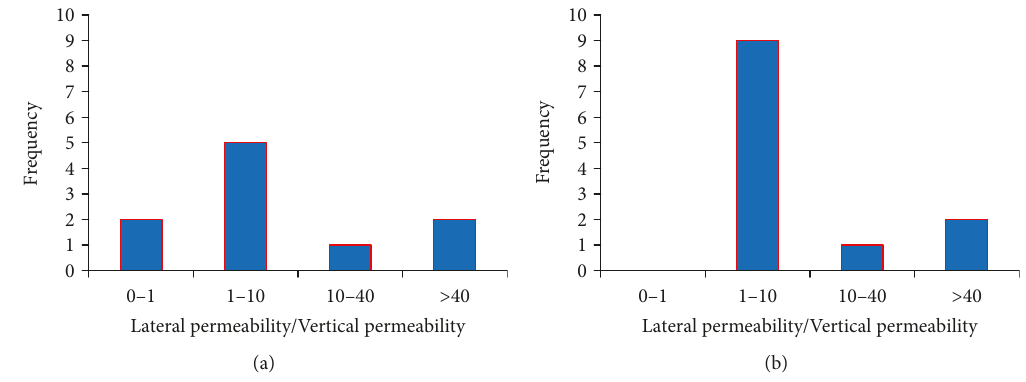
Figure 8: The ratio statistics between lateral and vertical permeability. (a) Samples of the Lower Cambrian Wangyinpu Formation shale, from the Jiangye-1 Well and Jiangye-2 Well. (b) Samples of the Lower Silurian Longmaxi Formation shale, from Pengye-1 Well. See Figure 1 for the well